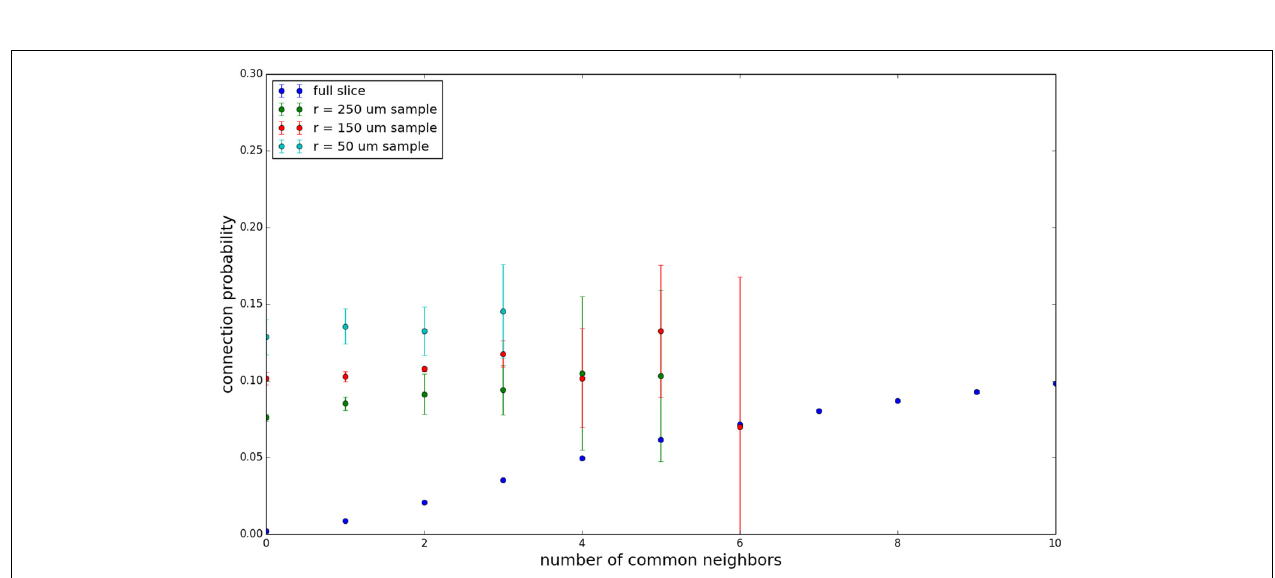
FIGURE 5 | Common neighbor clustering for 300 µ m slice: pairwise connection probability as a function of number of commonly connected neighbors. Error bars indicate standard error of the mean. Average over five populations.